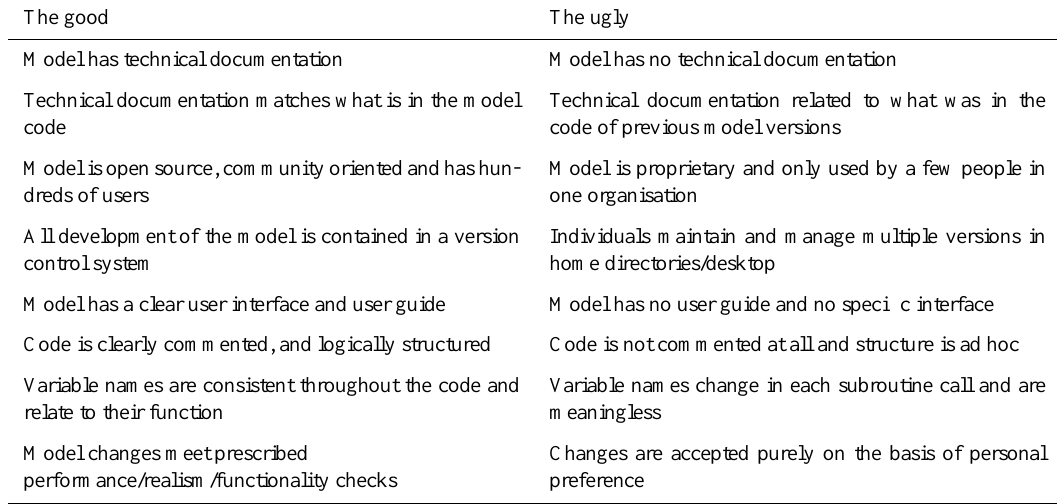
Table 1. A collection of commonly ignored model development issues that affect the reliability, useability and reproducibility of LSMs, represented by two caricaturized